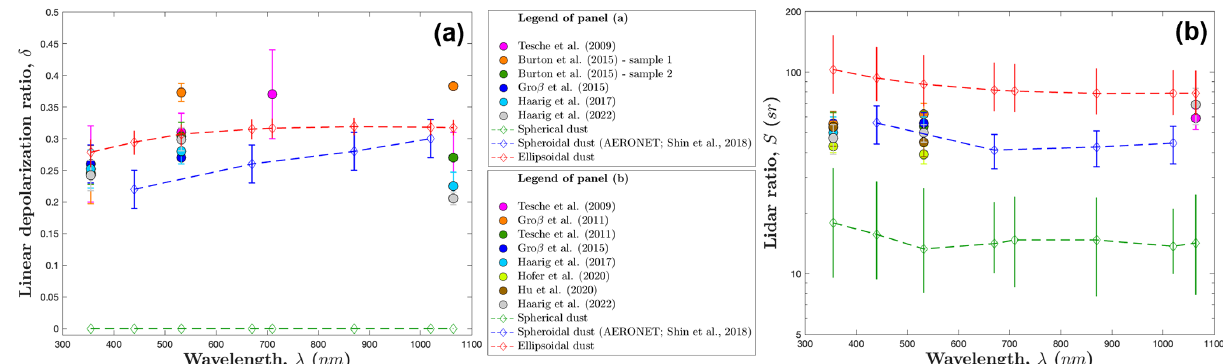
Figure 7. Comparison of the field-measured (a) linear depolarization ratio and (b) lidar ratio against the spherical, spheroidal, and ellipsoidal dust optics simulations as a function of light wavelength. In both plots, the closed markers denote field lidar measurements on Saharan dust aerosols (Tesche et al., 2009, 2011; Groß et al., 2011, 2015; Burton et al., 2015; Haarig et al., 2017, 2022) and Asian dust aerosols (Hofer et al., 2020; Hu et al., 2020). For the three simulations denoted in open markers, the vertical error bars denote uncertainties from the dust refractive index and dust shape distributions (see Sect. 2.2 and 2.3). The spheroidal dust optics are taken after Shin et al. (2018), who selected dust-dominated AERONET observations across the globe. The results of spherical and ellipsoidal dust optics simulations are presented at both the four AERONET wavelengths and the common lidar